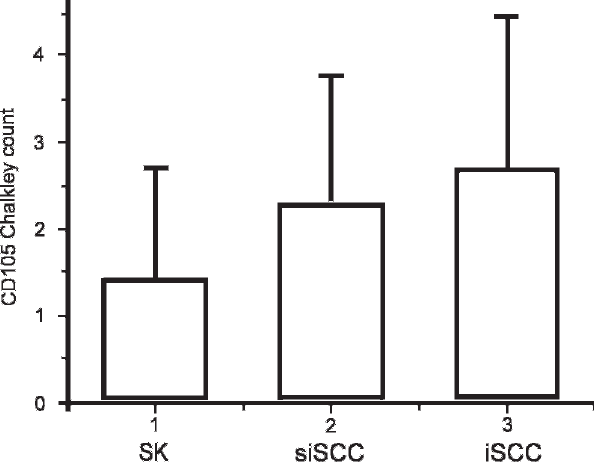
Figure 1 - CD105 mean Chalkley counts for solar keratosis (SK), superficially invasive squamous cell carcinoma (siSCC) and invasive squamous cell carcinoma